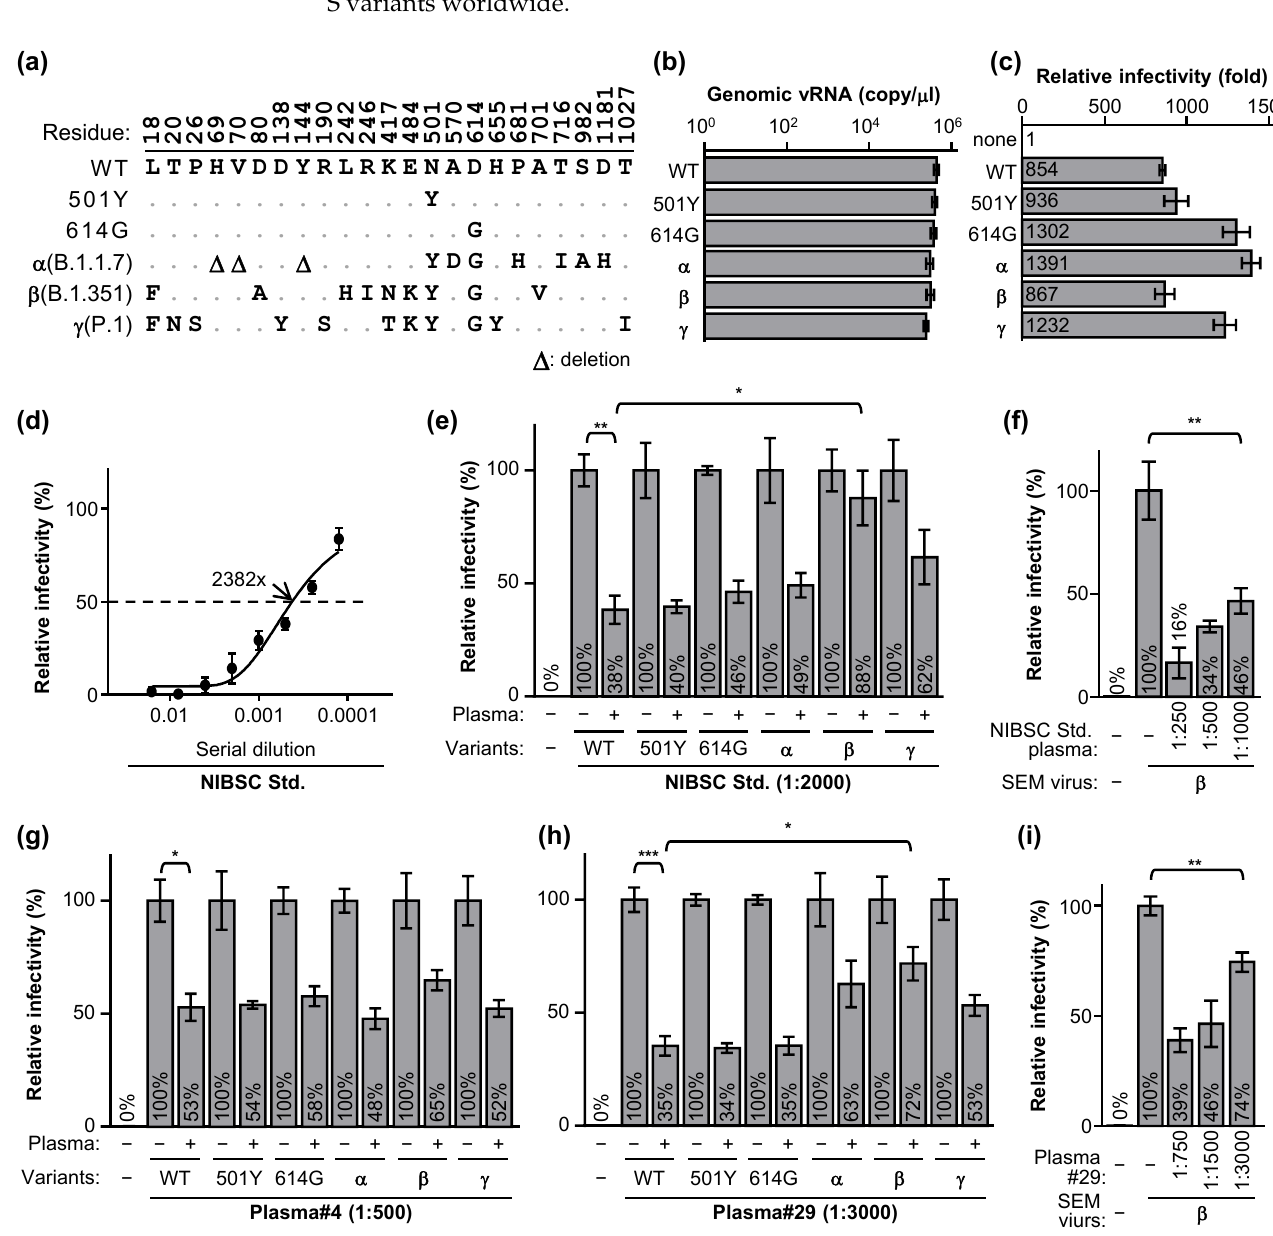
Figure 7. The SEM pseudovirion infectivity and convalescent plasma resistance vary with the S variants: ( a ) the indicated protein residues of the S variants for pseudotyping the SEM viruses were aligned. Variants: α , B.1.1.7; β , B.1.351; γ , P.1. ( b ) Each SEM pseudovirus preparation with the indicated S variant was titered by quantifying the genomic RNA of the virion. ( c ) The relative infectivity was measured by the luciferase activity in contrast to the mock infection group. ( d ) The NT50 of the NIBSC standard plasma against the WT SEM pseudovirus was calculated as 2382x by Prism 6. ( e ) The neutralization assay of each SEM virus in the presence (+) or absence ( − ) of the 2000-fold diluted NIBSC plasma. ( f ) The SEM virus harboring the β S haplotype was neutralized by the serially diluted NIBSC plasma. ( g , h ) The two Taiwanese human plasma #4 ( g ) and #29 ( h ) were diluted to neutralize each SEM virus as indicated. ( i ) Same as panel f but in the presence of the diluted #29 plasma as indicated. Data are mean ± SD, n = 3 per group, and were compared by two-tailed Student’s t test. *, p < 0.05; **, p < 0.01; ***, p <